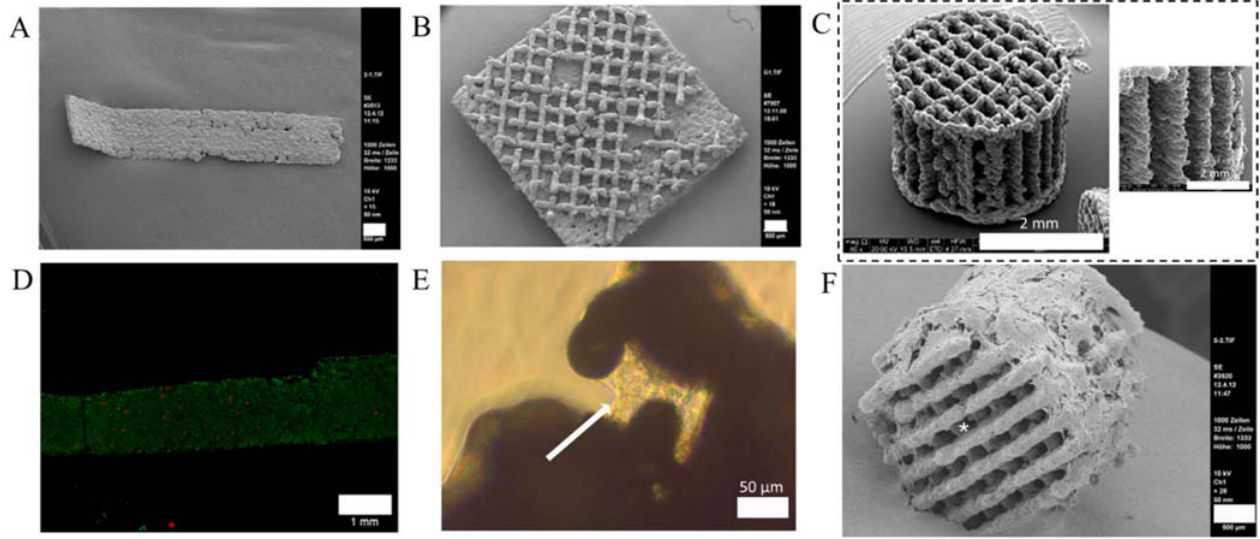
Figure 3. LPBF ‐ fabricated NiTi biomaterials: ( A ) flat, ( B ) mesh ‐ like, and ( C ) cage ‐ like. ( D ) ASC vitality on flat NiTi, ( E ) ASC attachment on mesh ‐ like NiTi, and ( F ) osteogenic ASC attachment on LPBF ‐ fabricated NiTi cages. Reproduced and adapted from [135] under Creative Commons Attribution 4.0 International License (CC BY 4.0).